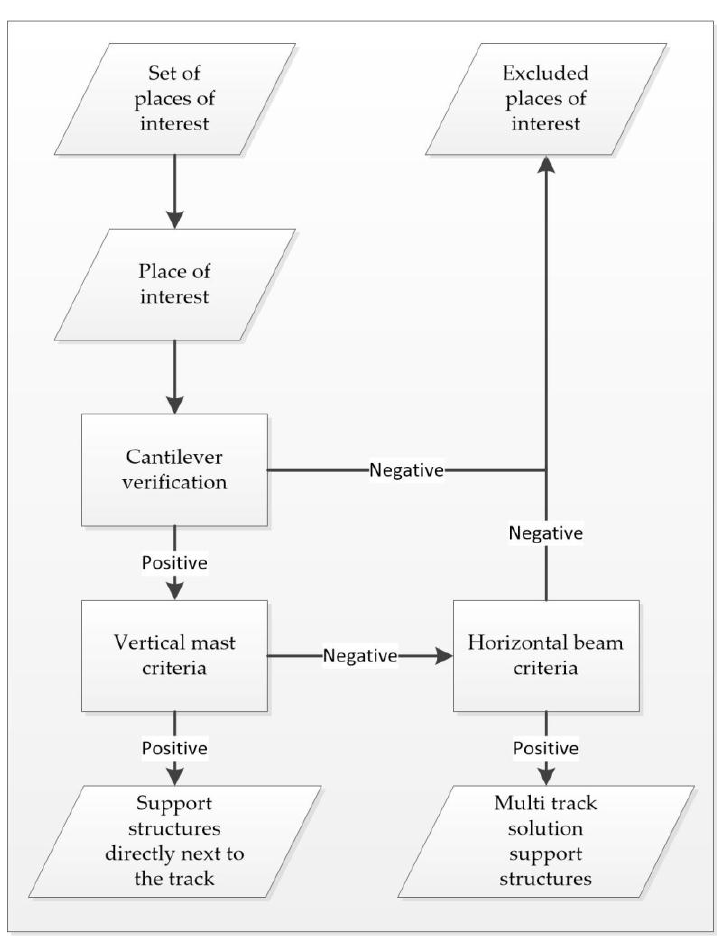
Figure 9. Simplified structure of the verification process.